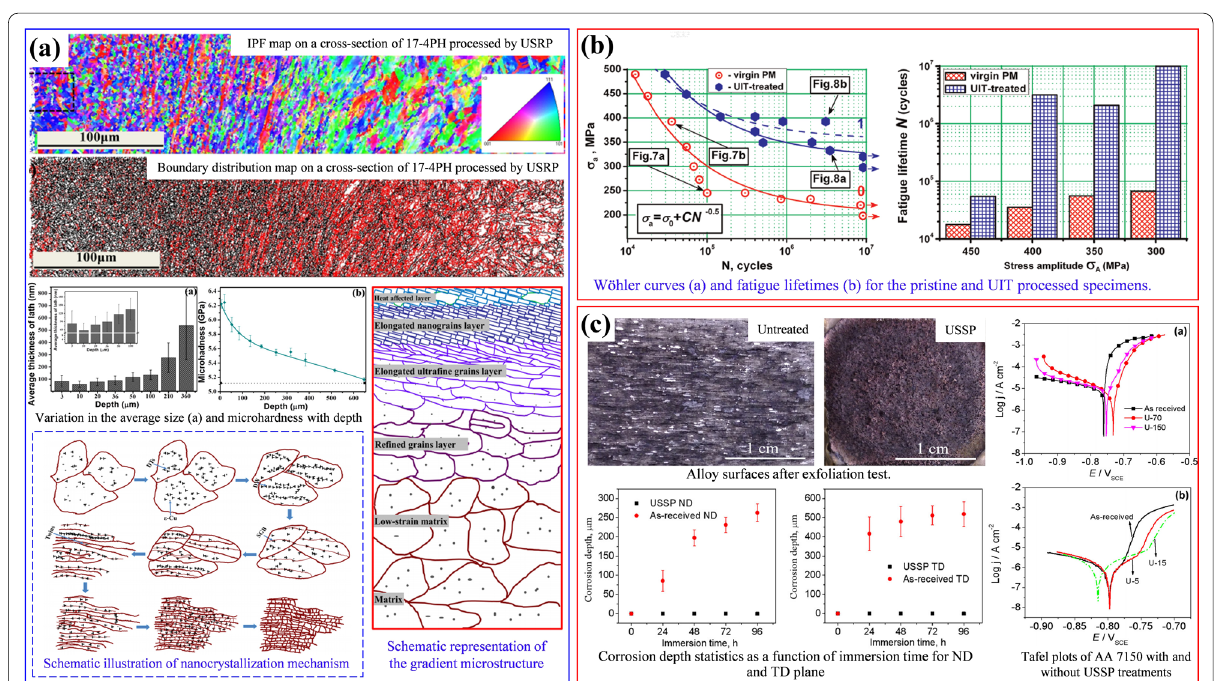
Figure 14 Strengthen surface structure via UST: a surface gradient microstructure [110], b improvement of fatigue resistance [106], c improvement of the corrosion resistance